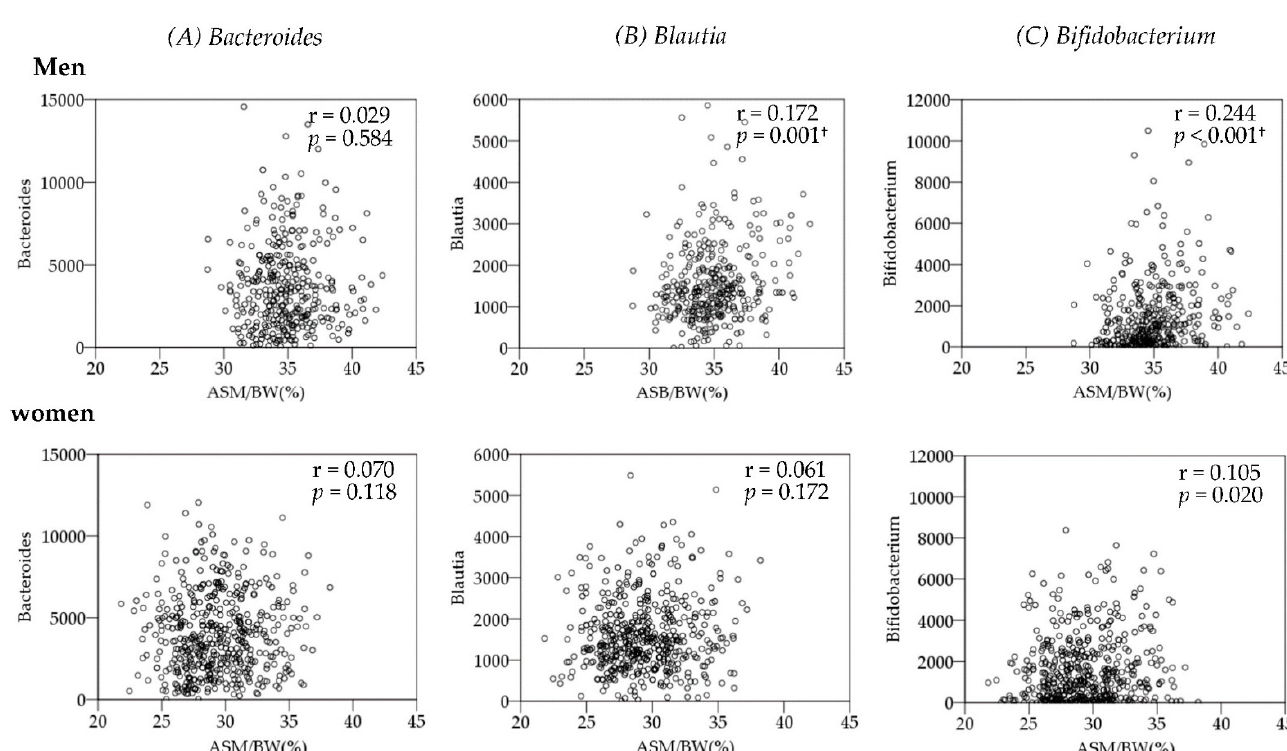
Figure 2. Spearman’s correlation between mean read count and ASM/BW of the three genera with the highest read counts. ( A ) Bacteroides , ( B ) Blautia , and ( C ) Bifidobacterium . † p-values that passed the FDR 0.05 threshold .